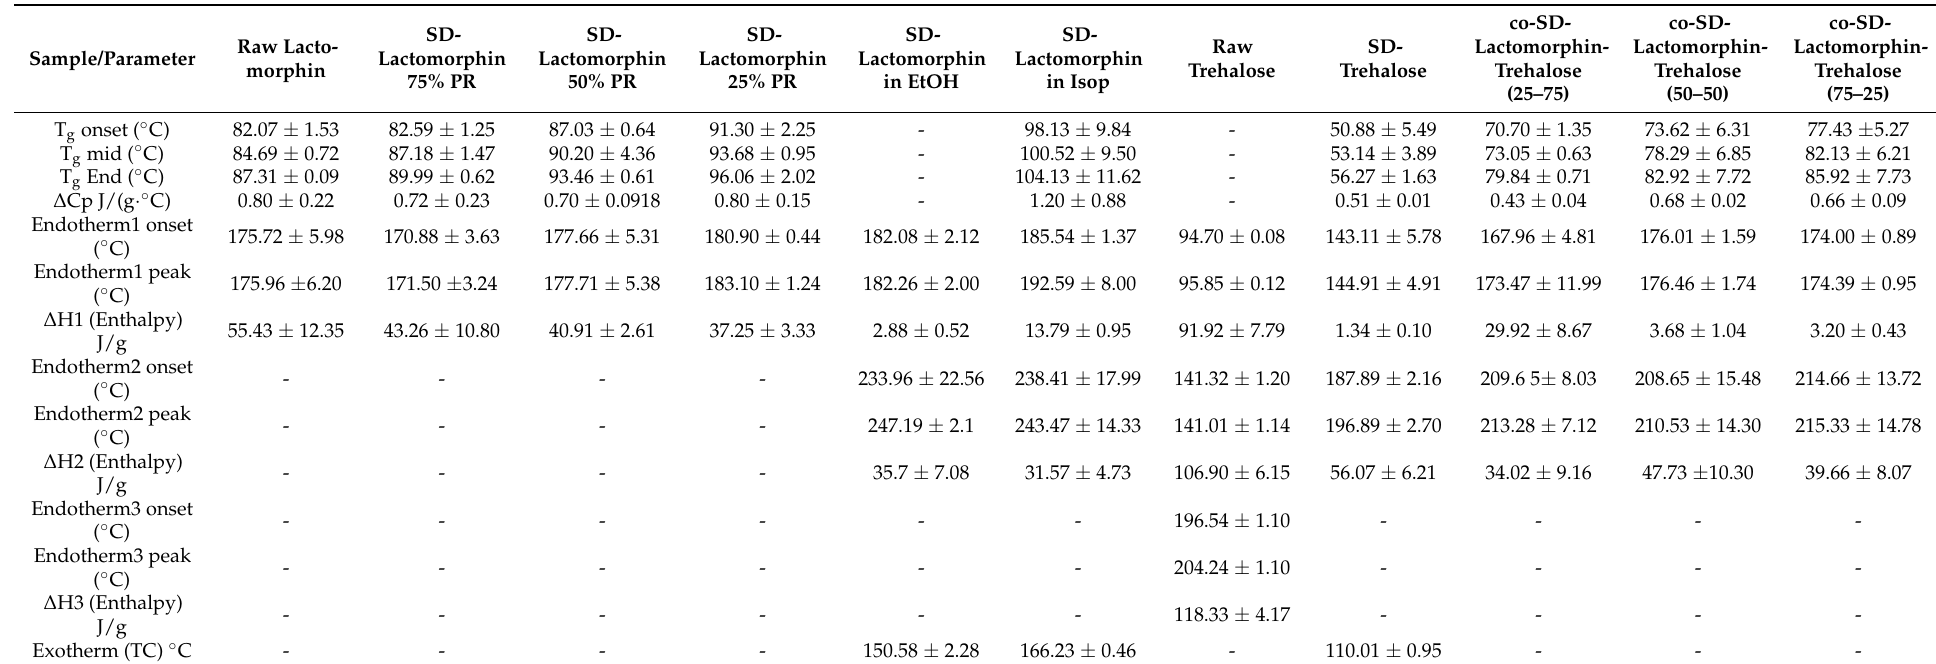
Table 3. DSC thermal analysis ( n = 3, mean ± standard